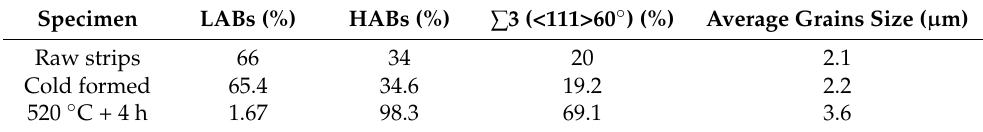
Table 4. GBs and average grains size of the EBSD